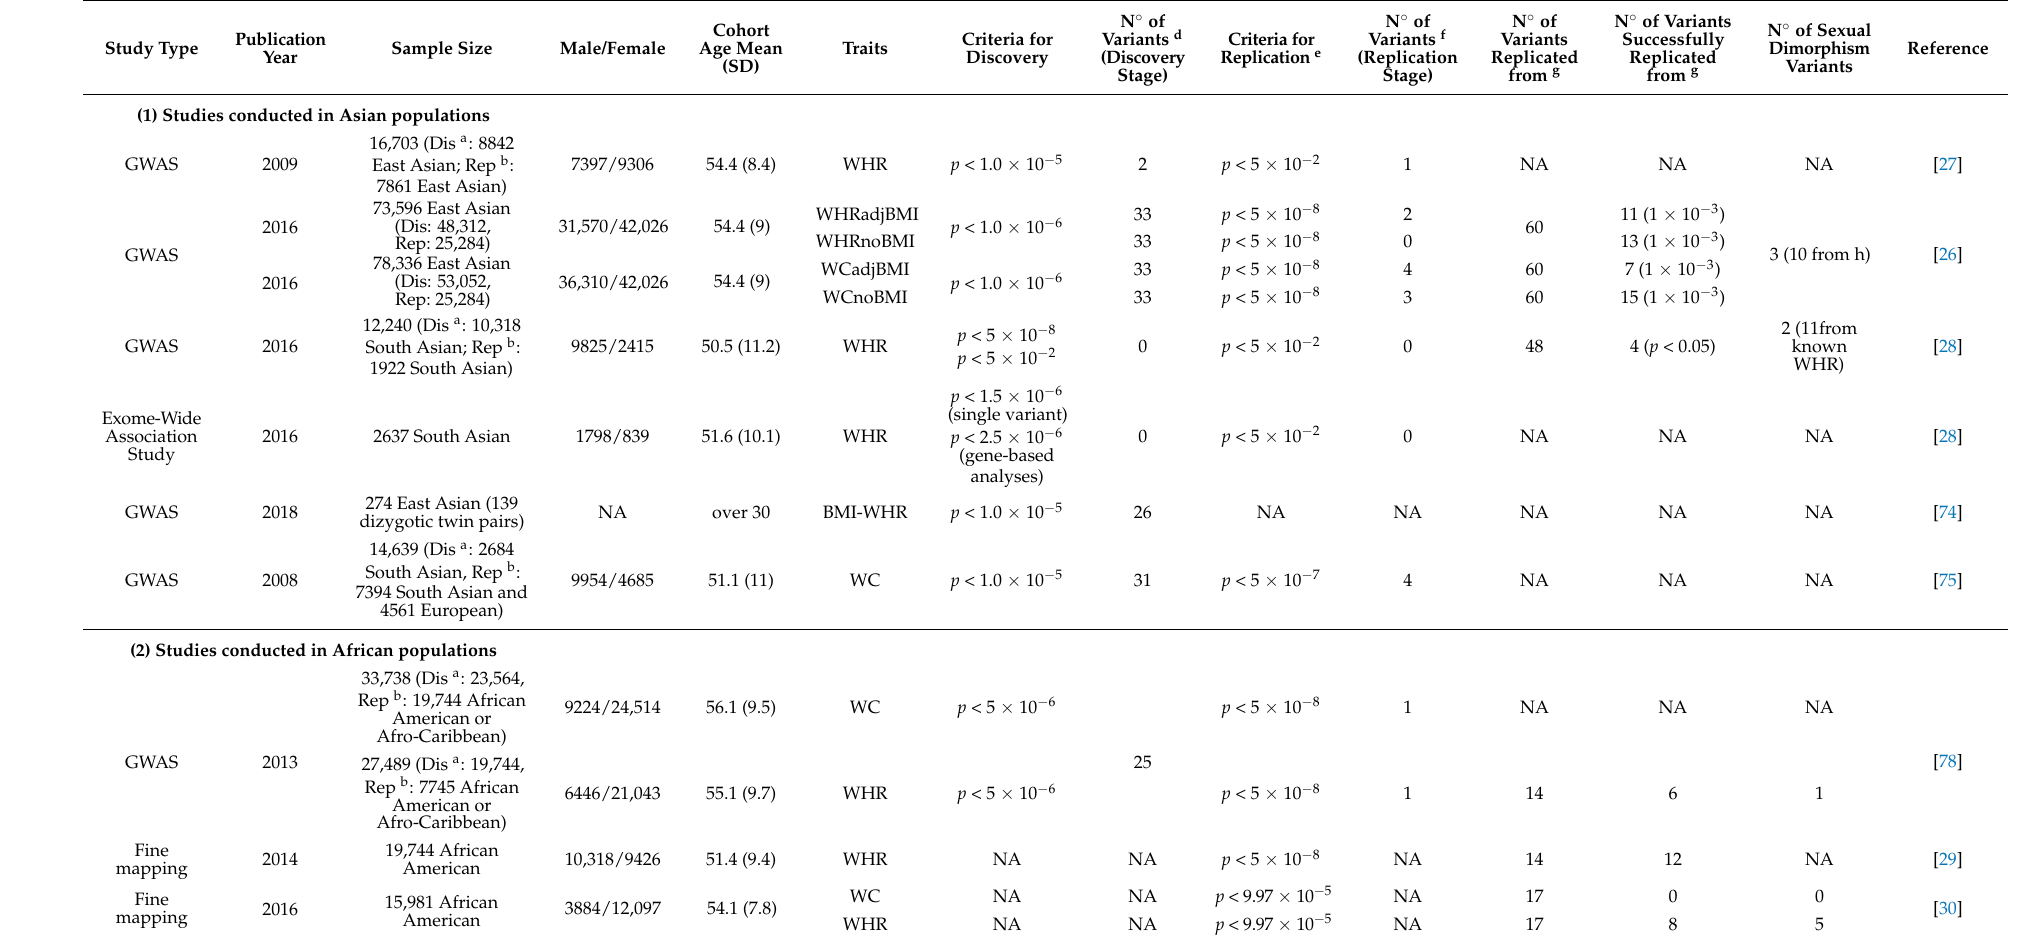
Table 2. Studies conducted in cohorts of Asians and